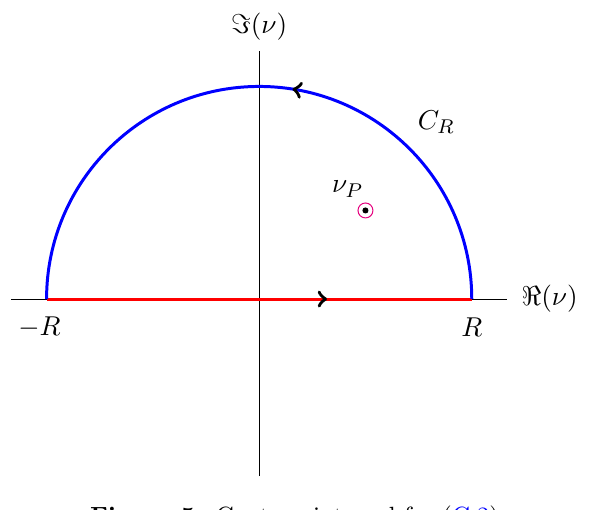
Figure 5. Contour integral for